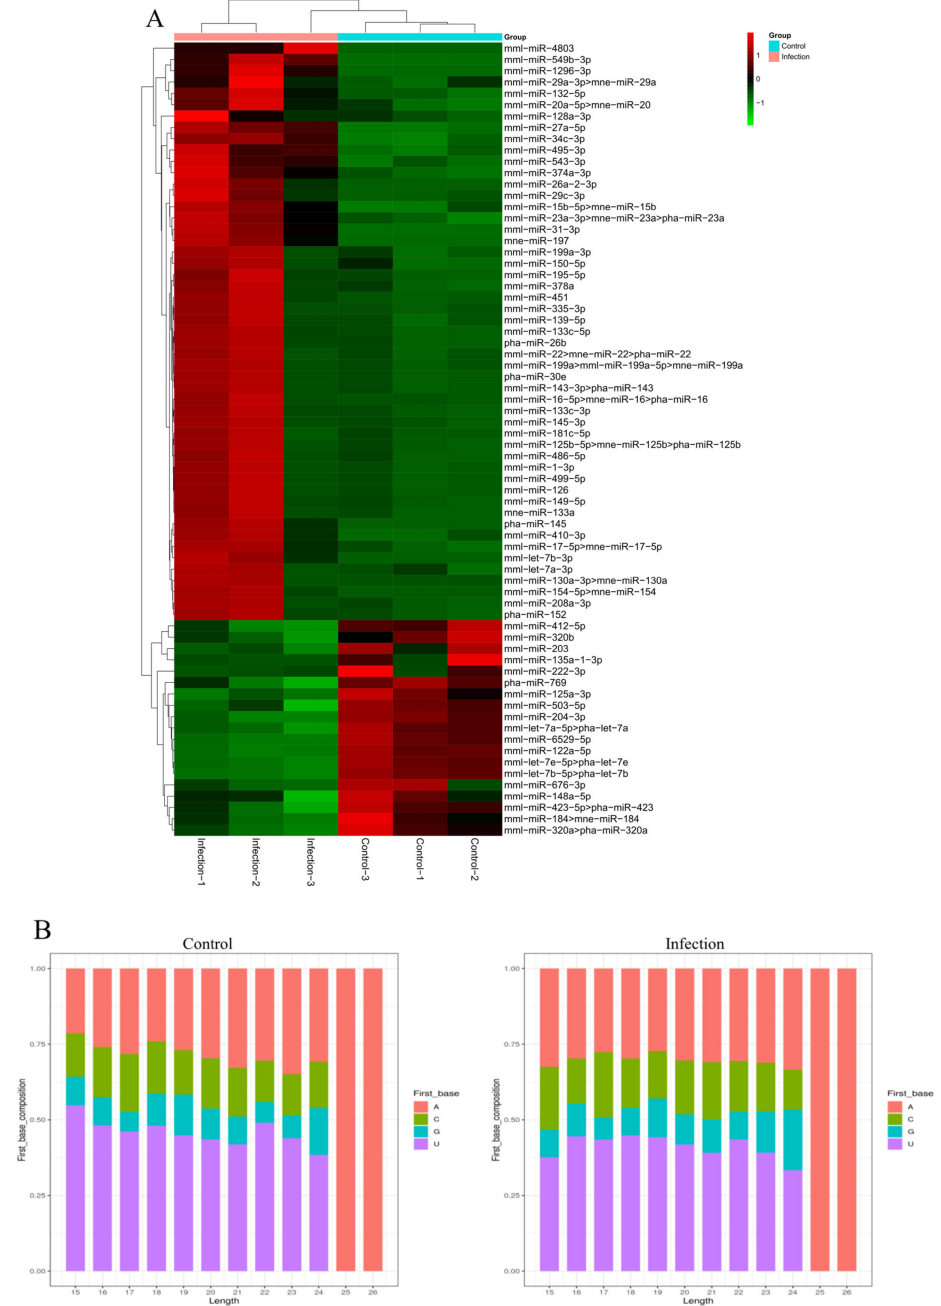
Figure 3. Differential expression levels of known miRNAs. ( A ) Hierarchical clustering analysis of known miRNAs in the PEDV-infected and control groups using the R program. Euclidean methods and complete linkage were used for this analysis. ( B ) Infected and uninfected cells have different sizes and base biases of miRNA at the first position. MiRNA lengths are given on the x-axis between 15and 26 nucleotides. MiRNA base bias is represented as a percentage at the first position of the